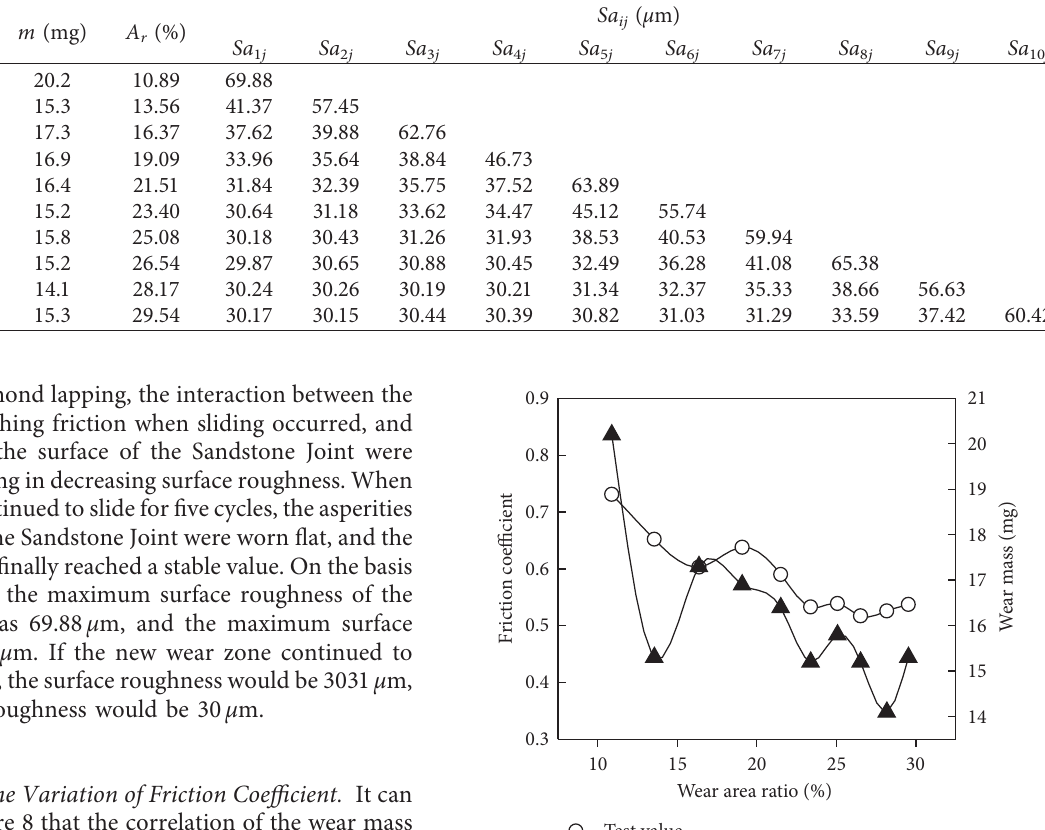
r ), and surface roughness of wear zone ( Sa ij ) with cycles.